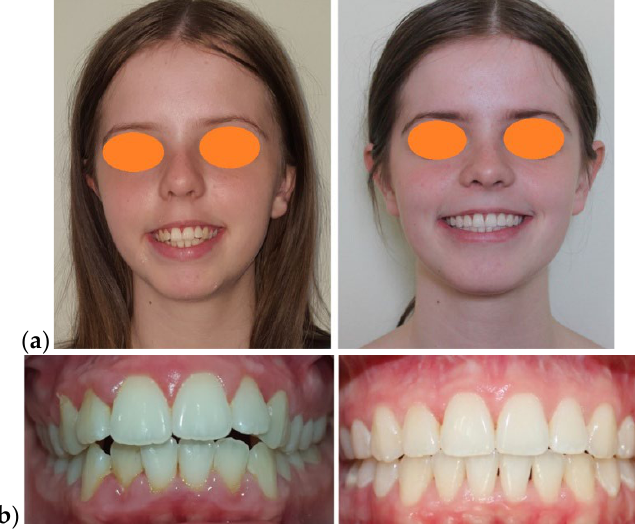
Figure 9. Comparative examination: ( a ) Facial aspect: frontal view smiling; ( b ) Intra-oral aspect: frontal view.